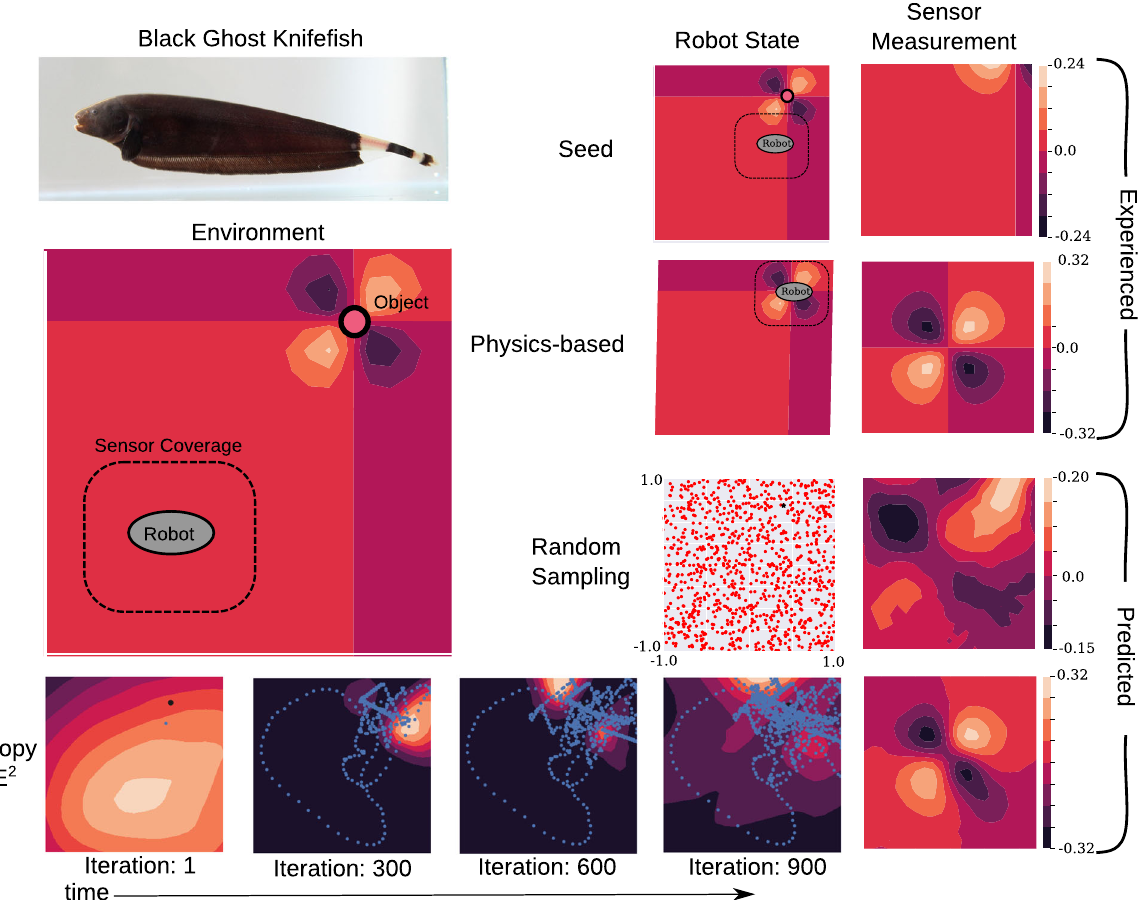
Fig. 2 Electrosense model learning. We compare the predicted measurement of the learned electrosensory model to the physics-based electrosensory model. The model is an approximation of the sensory system of a weakly electric fi sh (the black ghost knife fi sh 16 ). Using a seed image, we show the reconstruction of the physics-based measurement fi eld estimate near the object interest, using a conditional autoencoder with active learning using random sampling, and the proposed ergodic sampling strategy. The proposed approach explores the environment based on the evolution of the entropy of the latent space over time (shown evolving over time along with the resulting trajectory shown in blue). Despite no a priori information about the object's location (indicated with black markers) or measurement model, as time evolves the entropy of the latent space — representing where the information affecting the model estimate is highest — converges near the object location and the ergodic sampling spends signi fi cantly more time exploring that region without fi xating on a particular state. As a result, the ergodic sampling approach results in a signi fi cantly better reconstruction of the predicted sensor observation with much lower energy expenditure needed during